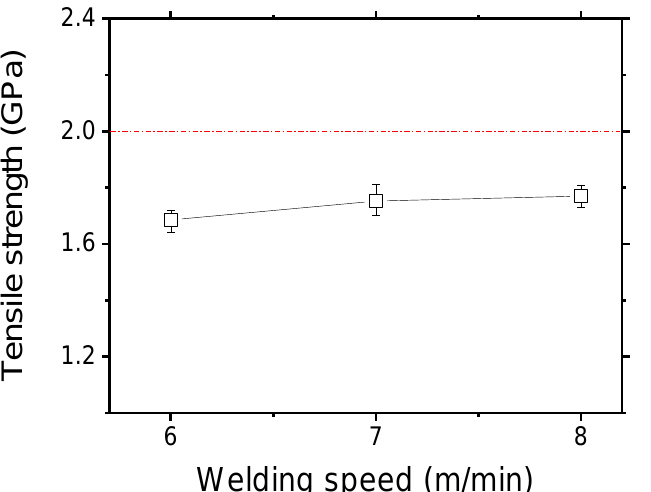
Figure 10. Tensile strength of bead-on-plate welds.